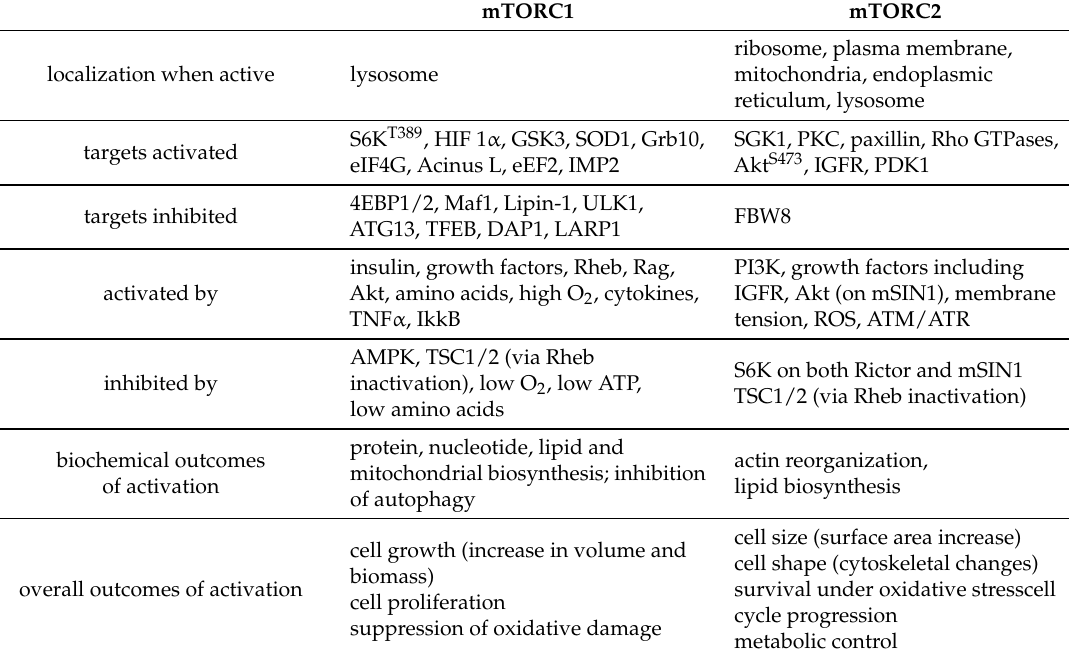
Table 2. Activities and localization of mTORC1 and mTORC2. Note that only a small subset of targets and modulators is shown. Proteins are named using standard nomenclature; for full gene names, please refer to the list of